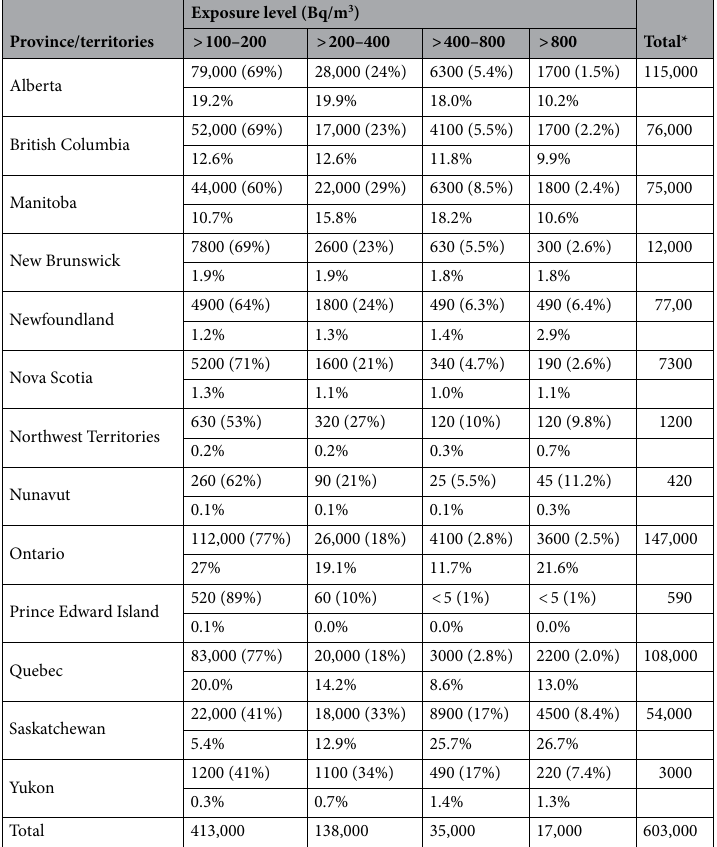
Table 1. Estimated prevalence of occupational exposure to radon by province/territory and level of exposure. *Number of exposed may not add up to total because of rounding; row percentage in bracket; column percentage under each estimated prevalence.